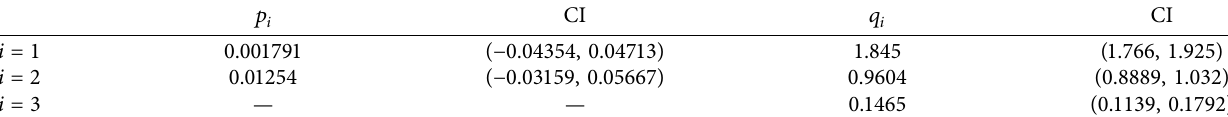
Table 17: Entropy vs. F .